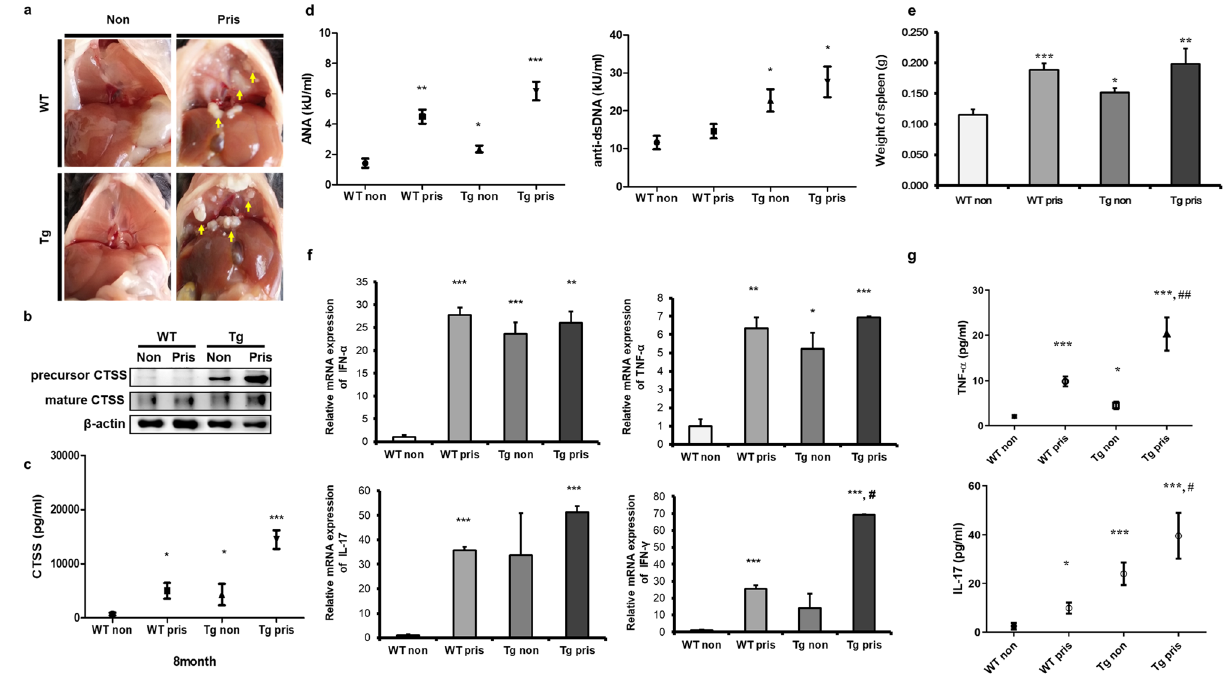
Figure 3. Increased cathepsin S (CTSS) expression induced by pristane injection with systemic lupus-like symptoms. ( a ) Lipogranuloma attached to the diaphragm (arrows) in WT and TG mice 8 months after pristane treatment. ( b ) Representative western blot showing CTSS expression in the spleen. β-actin was used as a loading control. Each band was cropped from same gel and grouped together. Original blots are shown in Supplementary Information. ( c ) Serum CTSS levels in WT and TG mice 8 months after treatment with or without pristane injection were measured by ELISA. Non pristane non-injected group, Pris pristane-injected group. ( d ) Serum ANAs and anti-dsDNA levels in WT and TG mice 8 months after treatment with pristane, as determined by ELISA. ( e ) Spleen weights of WT and TG mice treated with pristane. ( f ) IFN-α , TNF-α , IL-17 and IFN-γ cytokine mRNA levels in spleens from WT and TG mice measured by qRT-PCR. ( g ) Concentrations of TNF-α and IL-17 in sera, as determined by ELISA. Non pristane non-injected group, Pris